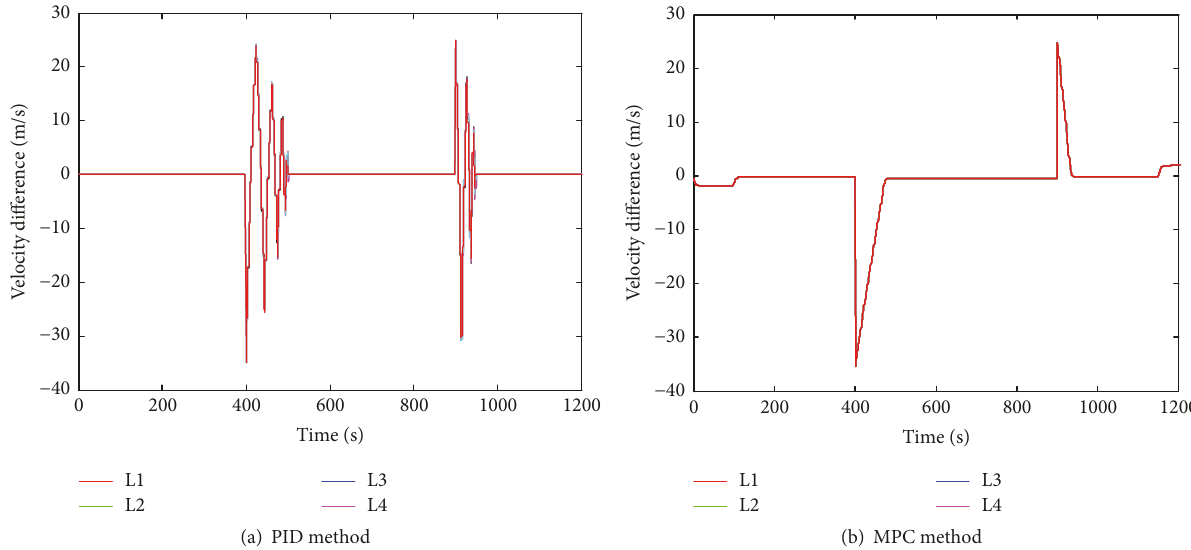
Figure 13: Comparison of MPC method with PID method in velocity error.